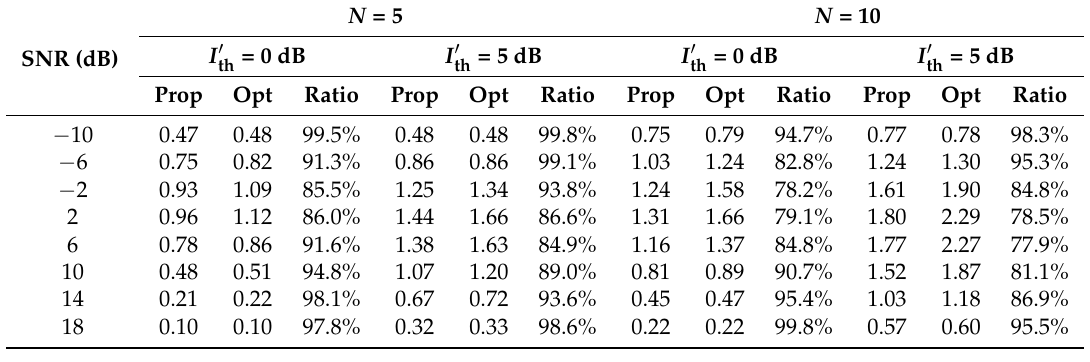
Table 1. Average sum-rates when all channels are i.i.d.